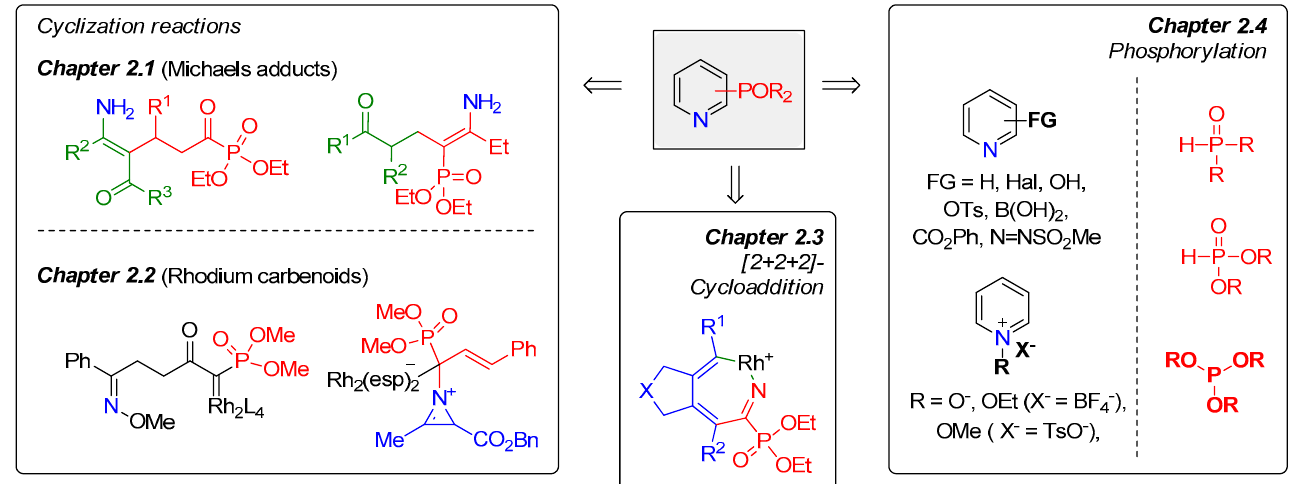
Figure 1. Approaches to synthesis of POR 2 -containing